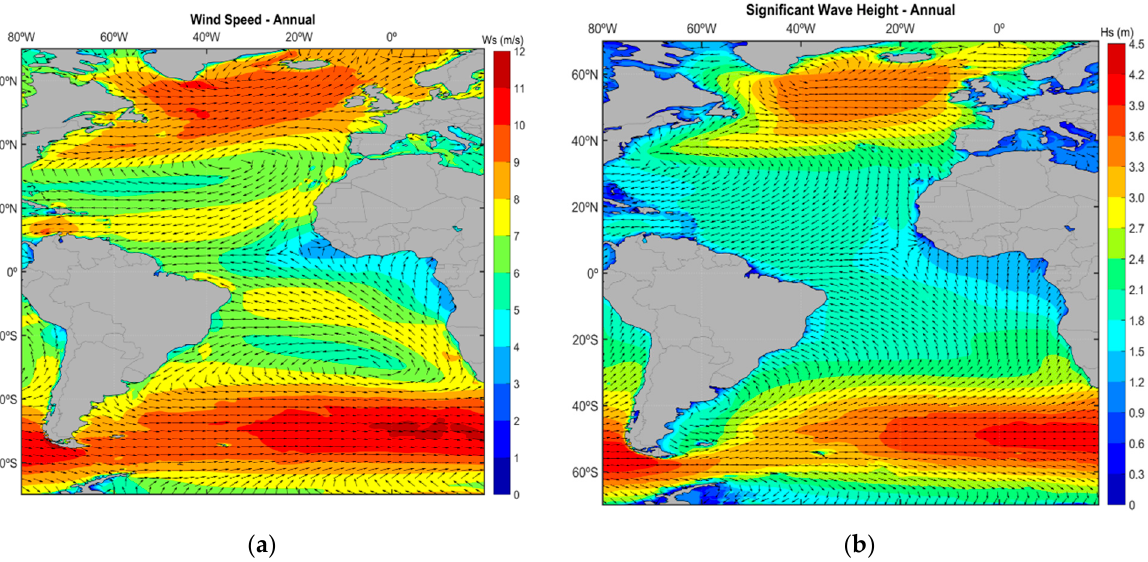
Figure 2. ( a ) Annual mean U 10 (m.s − 1 ) and ϕ ( ◦ ) for the Atlantic Ocean. ( b ) Annual mean H s (m) and θ m ( ◦ ) for the Atlantic